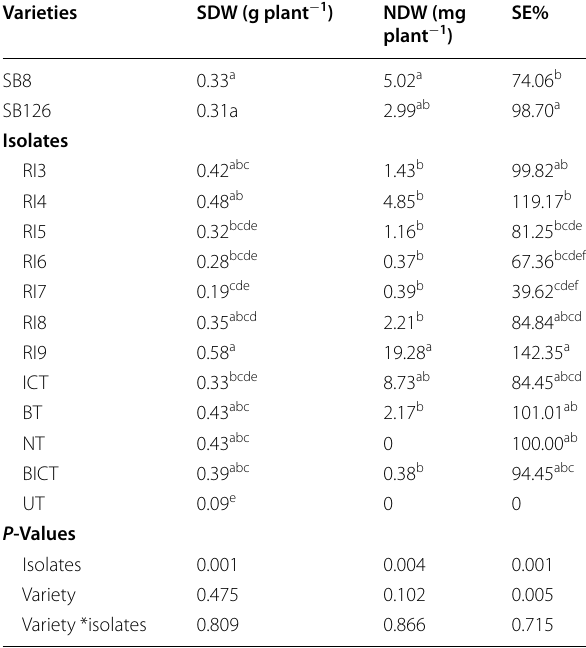
Table 2 Shoot dry weight, nodule dry weight, and symbiotic efficiency of two soybean varieties inoculated with bradyrhizobia isolates in the